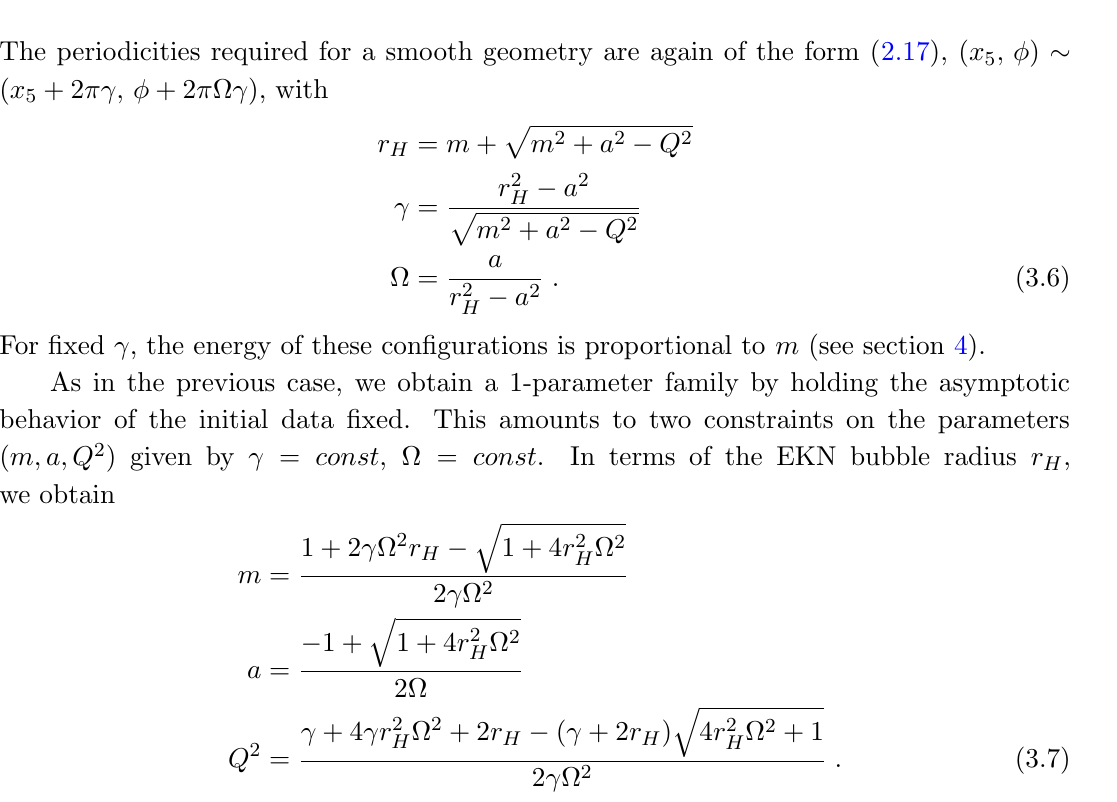
Figure 1 . A family of Euclidean Reissner-Nordstrom initial data with bubble radius r H and (cid:12)xed asymptotic circle size (cid:13) . The blue solid curve shows the parameter m , which is proportional to the energy. The black dashed curve shows the parameter Q 2 , magni(cid:12)ed for clarity. Flat space and the nucleation point of the Witten bubble lie at zero energy, while the static ES bubble sits at a maximum of the energy with Q =